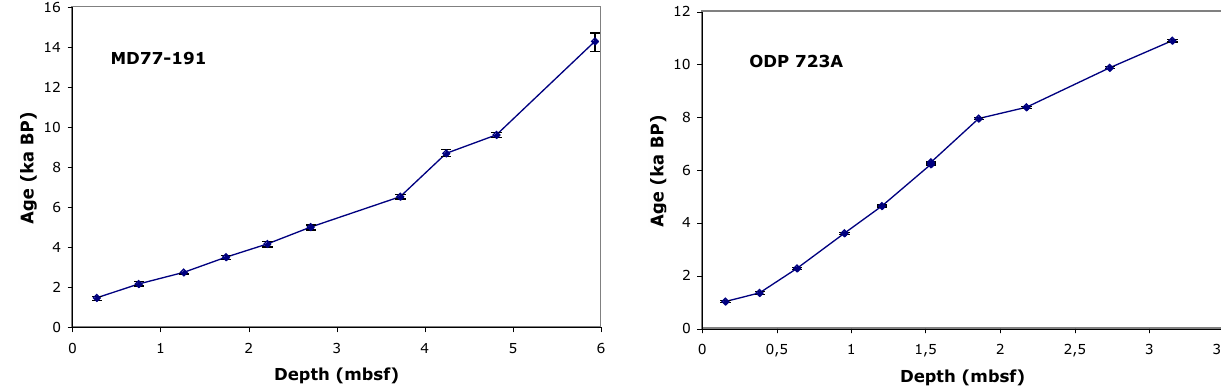
Fig. 3. Depth-age plots for core MD77-191 (left panel; see Table 2) and ODP site 723A (right panel; data from Gupta et al., 2003).